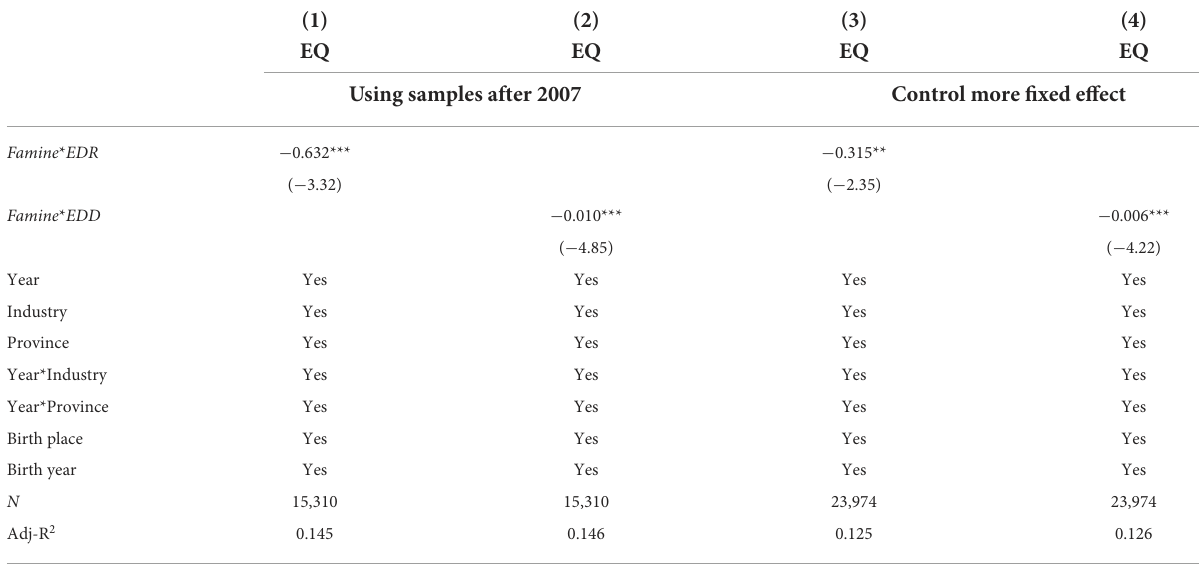
TABLE 11 CEOs’ famine experience and the quality of corporate earnings—using sub-sample after 2007 and adding more fixed